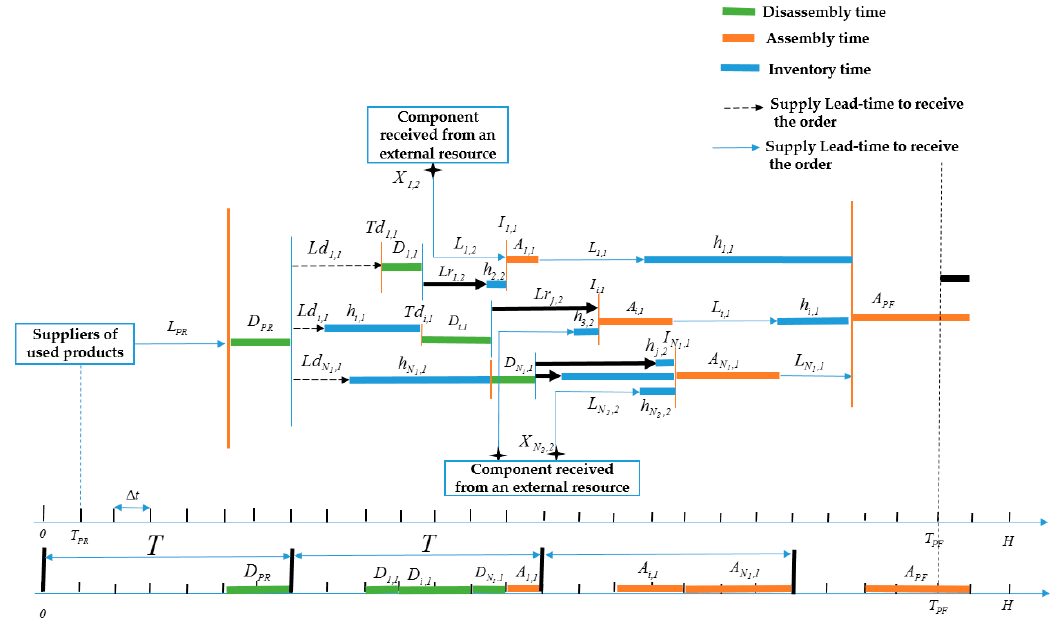
Figure 4. Description of one manufacturing finished product planning with a maintenance plan.